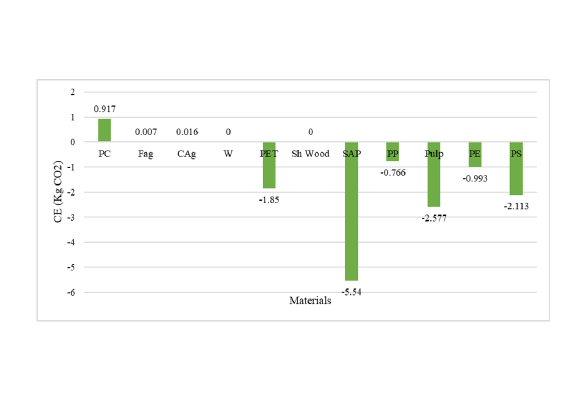
Fig. 6. Comparison of EE Value for 1 m 3